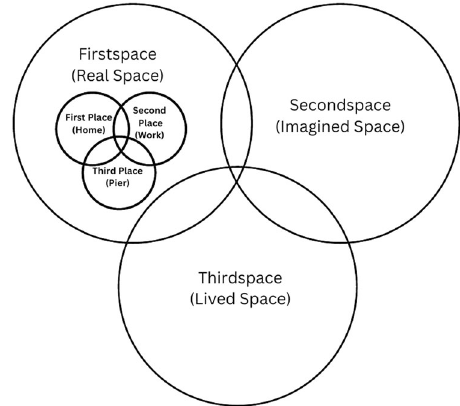
Fig. 1 Integration of Oldenburg ’ s concept of place and Soja ’ s concept of space. The larger triad indicates Soja ’ s concept of space, and the smaller triad indicates Oldenburg ’ s concept of place. (The fi gure used in the manuscript is an original, unpublished